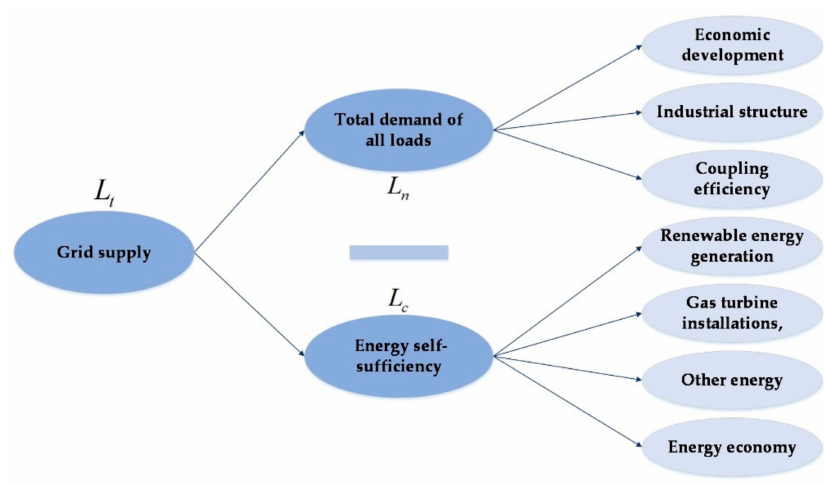
Figure 5. Load demand calculation with the power grid as the calculation